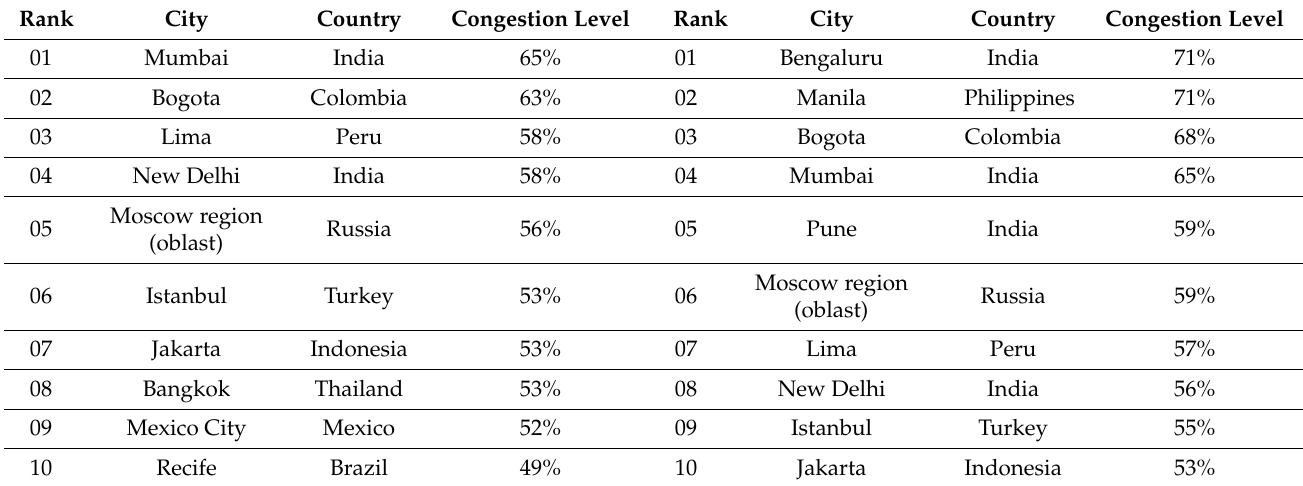
Table 2. Traffic congestion level of the top 10 cities all around the world